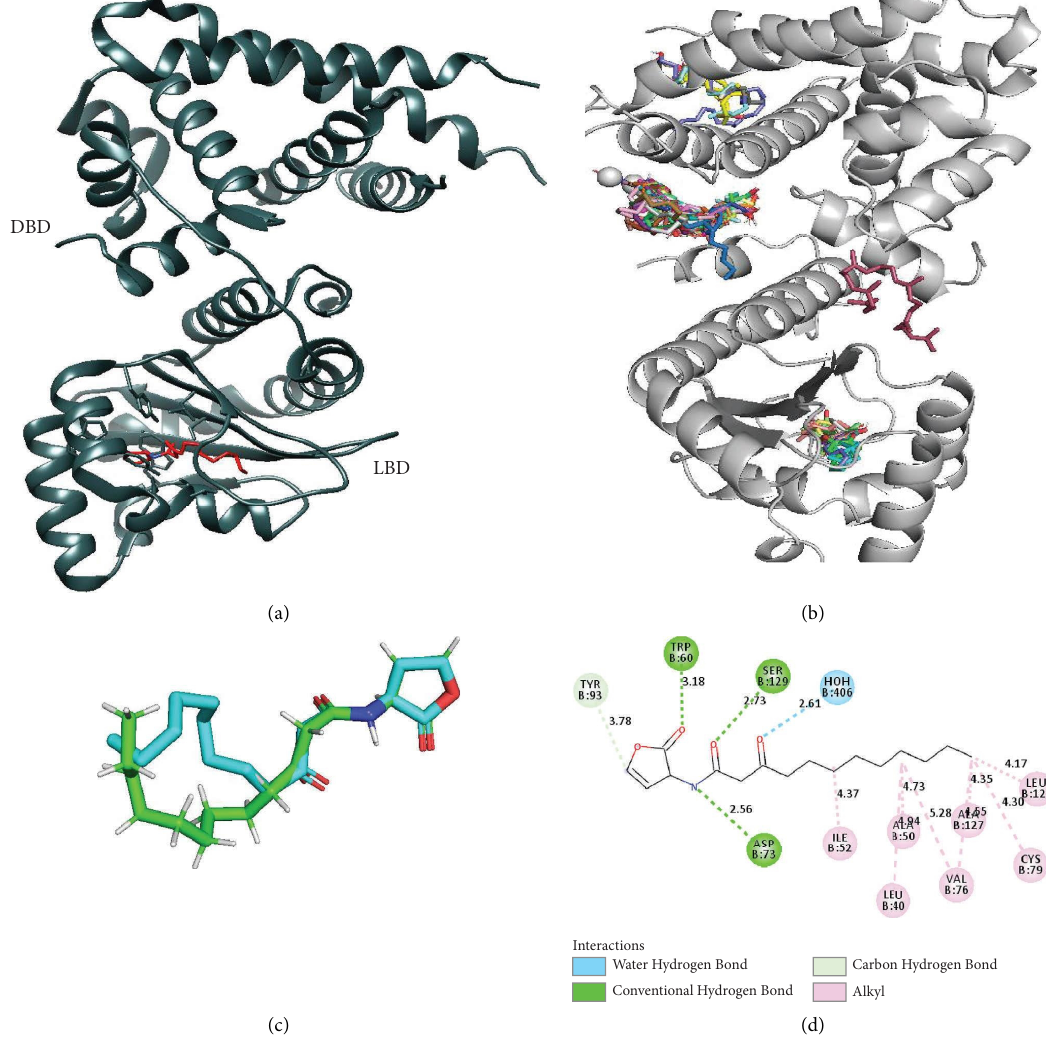
Figure 3: Te transcriptional activator, LasR: (a) crystal structure of Las R enzyme of P. aeruginosa in complex with AHL. In red is the AHL molecule (DBD: DNA binding domain, LBD: ligand/AHL binding domain); (b) global docking of compounds from the essential oils of V. doniana showing the compounds which preferred to bind in the ligand binding domain of LasR; (c) superimposition of redocked and crystallized poses of AHL against Las R of P. aeruginosa . Crystallized pose in green, and redocked pose in cyan. An RMSD of 0.231 ˚A was observed. Redocking of AHL produced a binding afnity of − 8.4kcal/mol; (d) 2D interactions of AHL at the Las R binding